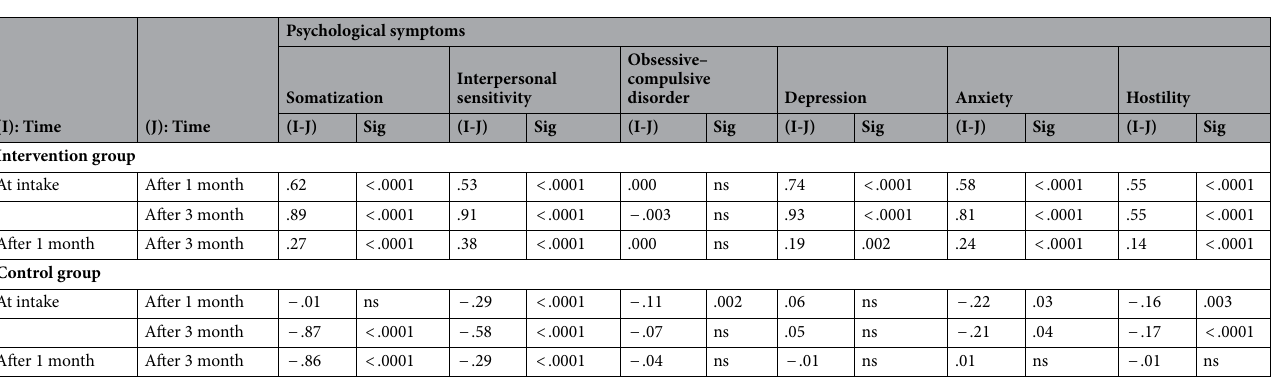
Table 3. Pairwise comparison of the psychological symptoms in two groups by three times. ( I - J ) Mean Difference; sig significance; ns not